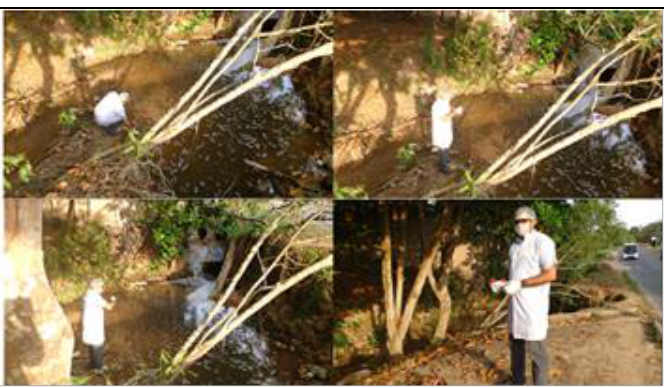
Figura 4: Igarapé do quarenta no bairro nova república. Fonte: Autores, (2018).